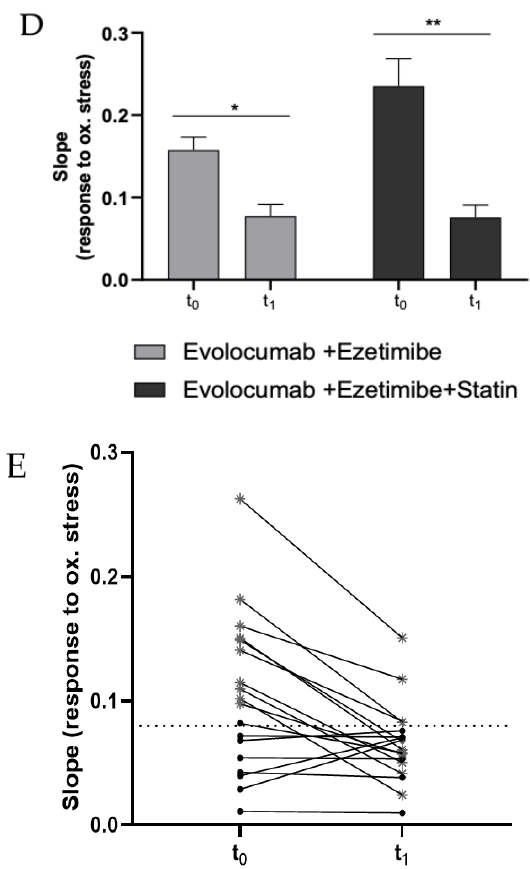
Figure 2. ( A ) Dose–response graph showing the correlation between the CL signal and the con- centration of freshly isolated PBMCs from a healthy volunteer (range 0–2 × 10 5 cells). Each point represents the mean ± SD of three independent measurements. ( B ) Dose–response graph showing the correlation between the CL signal and the concentration of freshly isolated PBMCs from a hypercholesterolemic subject before (t 0 ) and after (t 1 ) two-month treatment with Evolocumab. Each point represents the mean ± SD of three independent measurements. ( C ) Changes of H 2 O 2 production (as log-ratios) by PBMCs isolated from 18 hypercholesterolemic subjects observed after two-month treatment with Evolocumab (H 2 O 2 production was evaluated as the slope of the CL signal versus PBMCs concentration graphs). ( D ) Slope values before and after Evolocumab treatment (the slope was calculated from the calibration curve obtained correlating the CL signal versus PBMCs concentration pre- and post-treatment). * p < 0.05, ** p < 0.01 significantly different from t 0 values. ( E ) Changes of H 2 O 2 production by PBMCs isolated from 18 hypercholesterolemic subjects observed before (t 0 ) and after (t 1 ) two-month treatment with Evolocumab (H 2 O 2 production is expressed as the slope value of each curve derived by CL signal versus PBMCs concentration graphs).